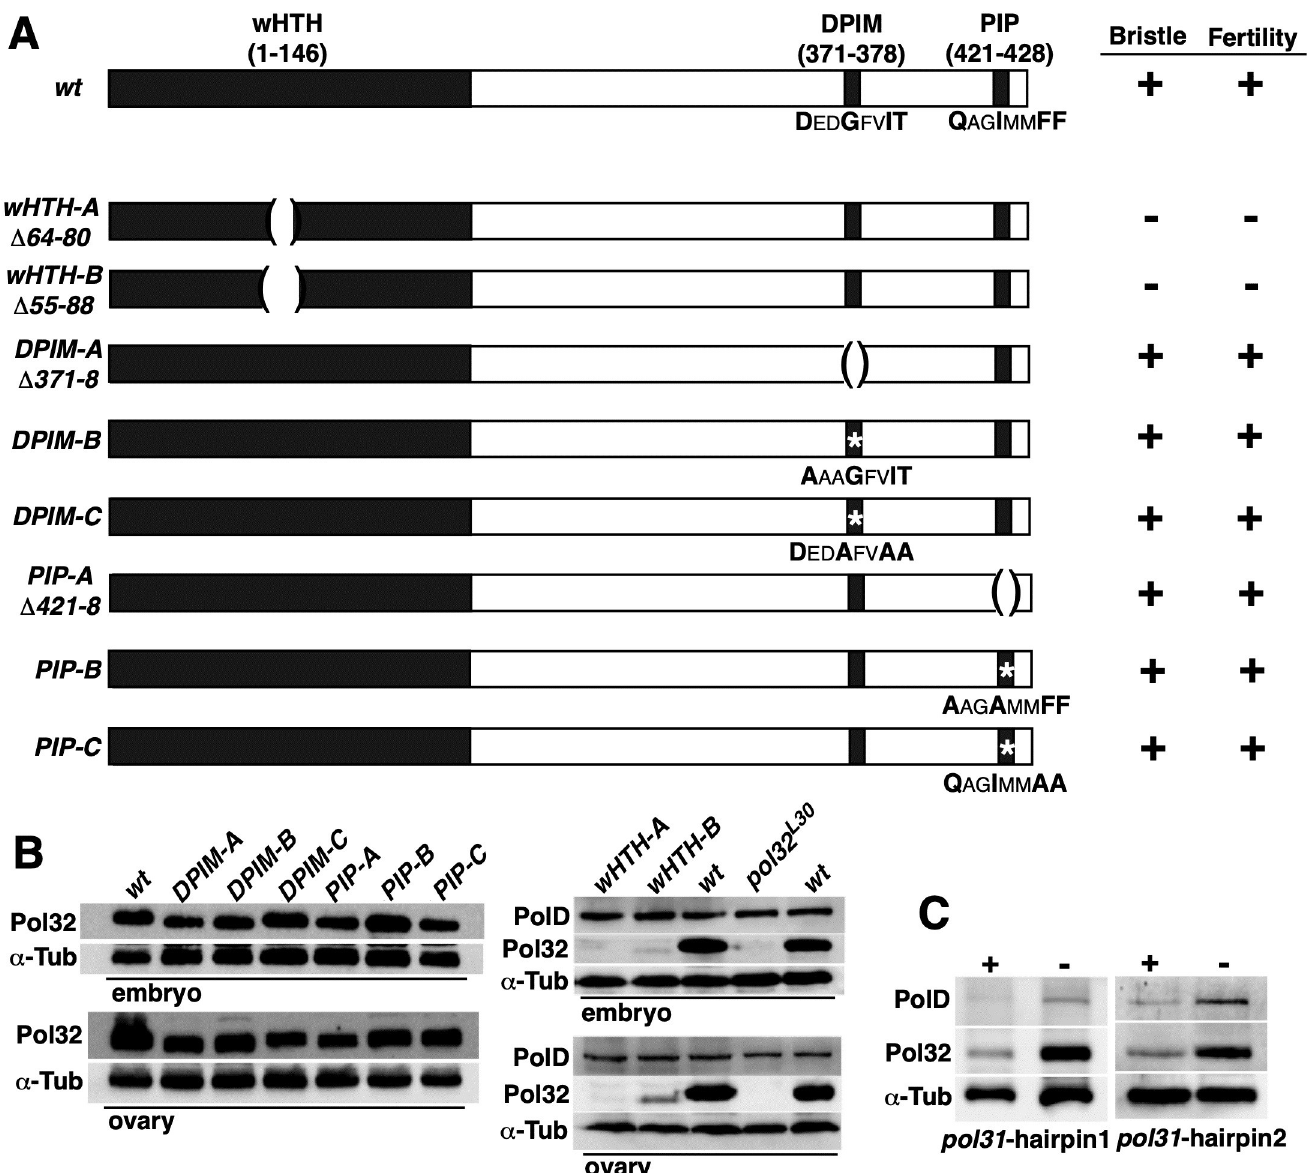
Fig 6. Pol32-Pol31 interaction is essential for Pol32 function. A . Constructs used in rescuing experiments and their effects on the mutant phenotypes. The 431aa Pol32 protein is denoted as a rectangular box with domains of interest labelled in black. The names of the domain are on top of the boxes with the range in amino acids in parentheses. For the Pol α -interacting DPIM and the PCNA-interacting PIP domain, the amino acid sequences of the domain are listed underneath with the conserved residues in Bold and a larger Font. For constructs with a deletion, the deleted range in amino acids is shown under the name of the mutant construct and proceeded by a “ Δ ”. For constructs with residues changed to Alanine, the mutant composition of the mutated domain is shown underneath and the mutated domain denoted with an “ � ”. The constructs were tested for their abilities to rescue two mutant phenotypes. “Bristle” indicates shorten or missing bristles in pol32 adults. “Fertility” indicates female sterility of pol32 mutants. “+” indicates that a construct can recue the phenotype when introduced into a pol32 mutant background, while “-” cannot. B . The levels of Pol32 mutant proteins. Western blots using total extracts from either ovaries or embryos were probed with antibodies indicated to the left of the images. The animals are pol32 homozygotes with a rescuing construct listed on top of the images and shown in A . Tubulin was used as a general loading control. For the two wHTH mutants, the level of PolD was also measured (right panels in B ). C . The effect of Pol31 RNAi on the level of Pol δ . Two transgenes carrying different RNAi hairpins were used to knockdown Pol31 in larval tissues. The levels of Pol32 and PolD were assayed by Western blotting. “+” indicates samples from animals with the hairpin construct, while “-” from control animals without the construct.